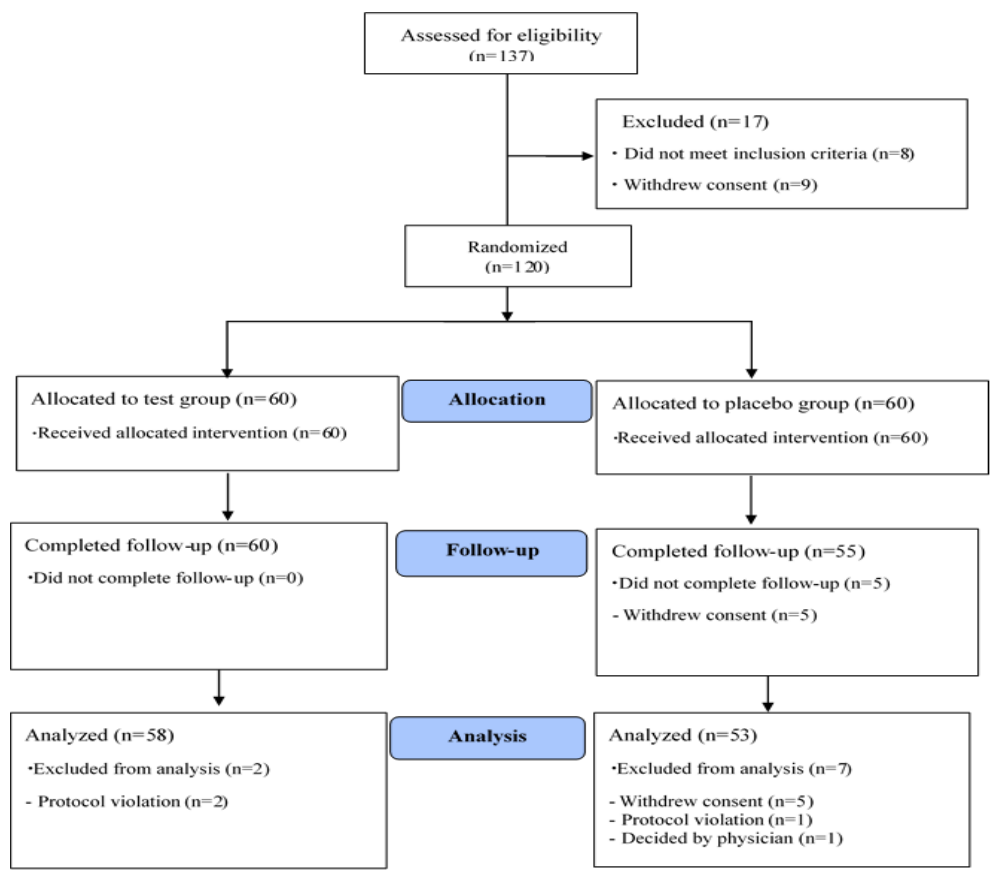
Figure 2. Flow chart of study participants. Table 2. Baseline general characteristics of the subjects.